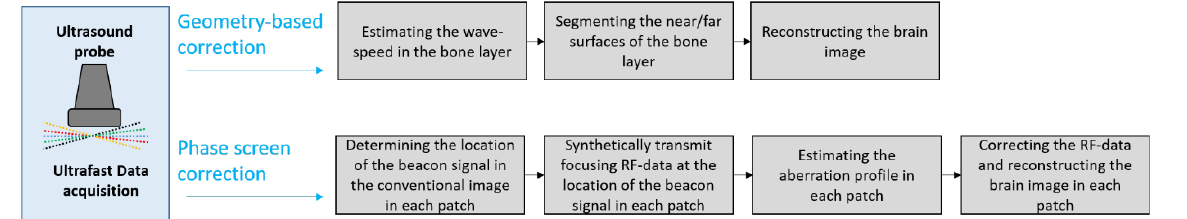
Figure 1 . The block diagram showing the processing procedure for the geometry-based and phase- screen aberration correction techniques when an ultrafast imaging sequence (multi-angle plane wave) is used for data acquisition.